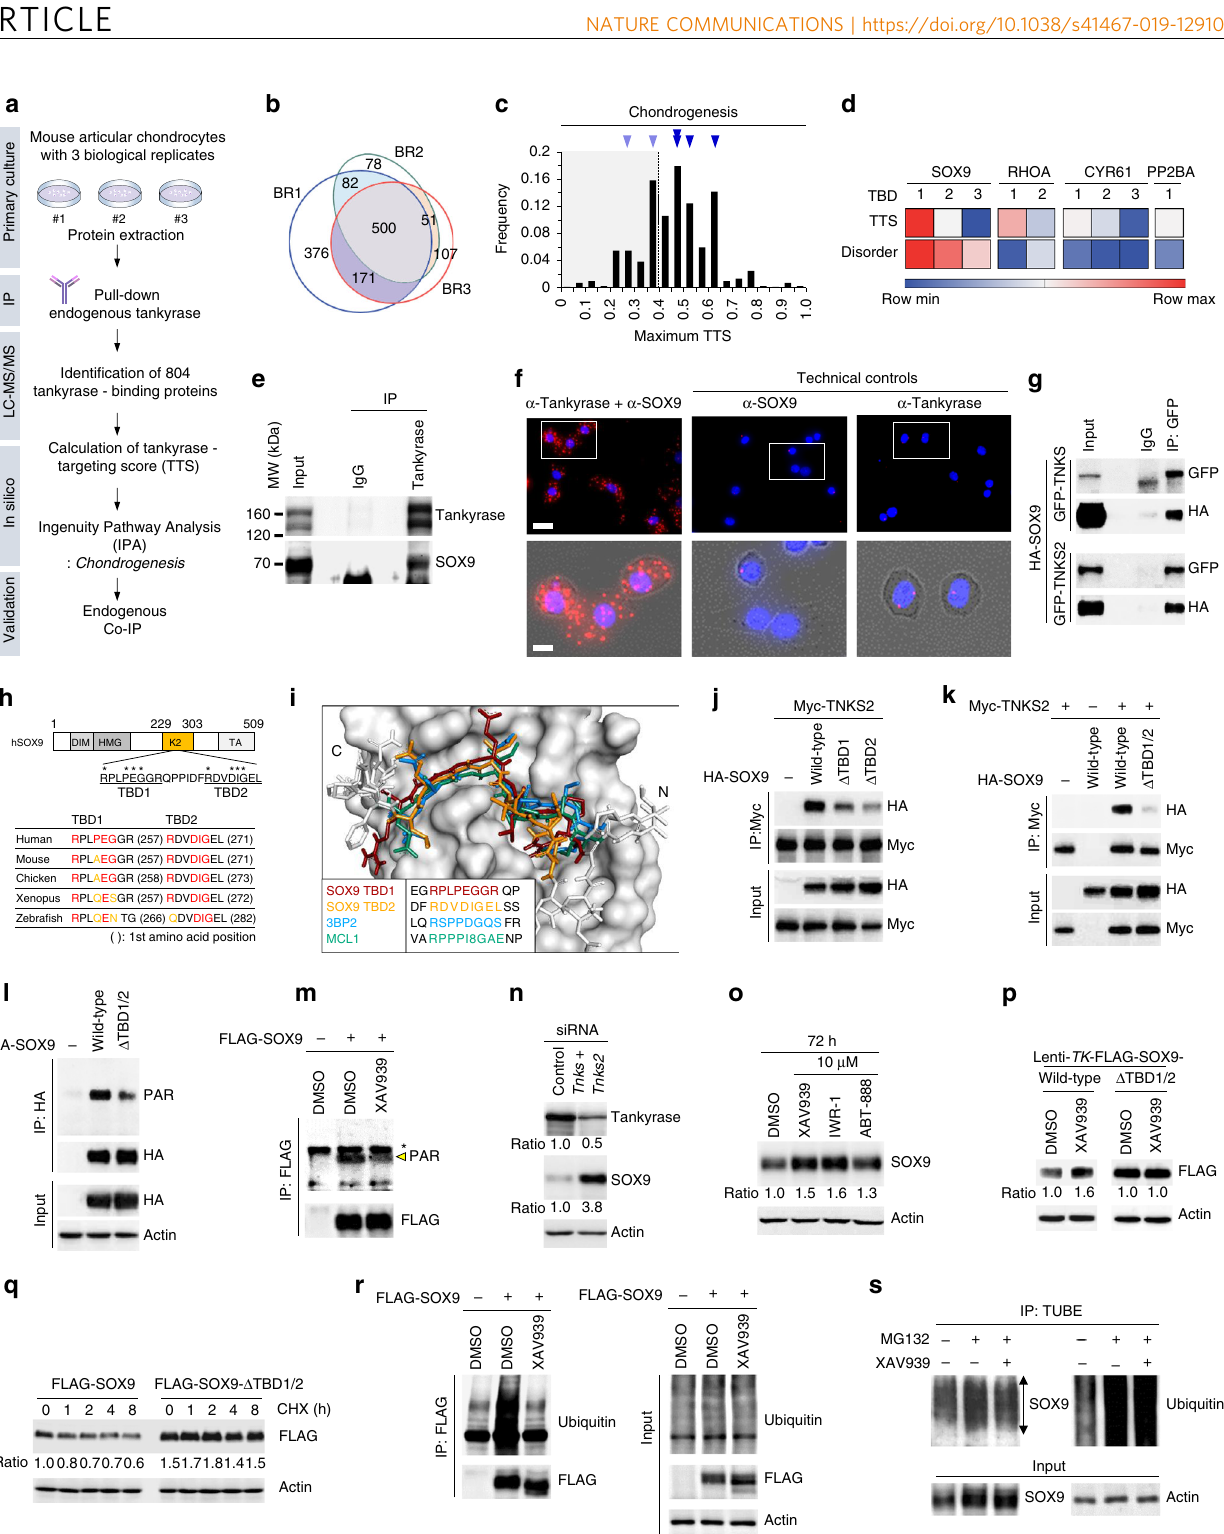
TBD1 RPLPEGGR (257) RDVDIGEL (271) RPLAEGGR (257) RDVDIGEL (271) RPLAEGGR (258) RDVDIGEL (273) RPLQESGR (257) RDVDIGEL (272) RPLQEN TG (266) QDVDIGEL